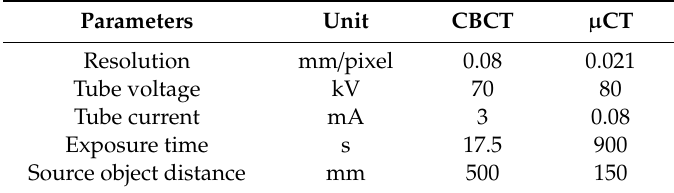
Table 1. Parameters of applied radiologic imaging techniques.